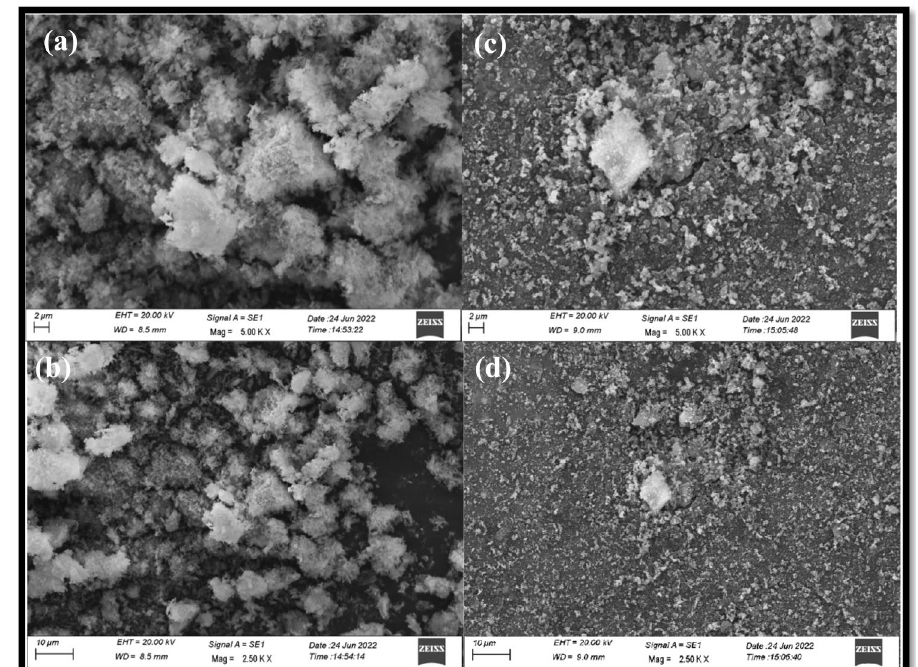
Figure 4. ( a , b ) Pure SrAl 2 O 4 (SAE 0.00) phosphor, (c , d) Eu 2+ doped Sr 1−x Al 2 O 4 :Eu x (x = 0.05) (SAE 0.05) phosphor SEM image.